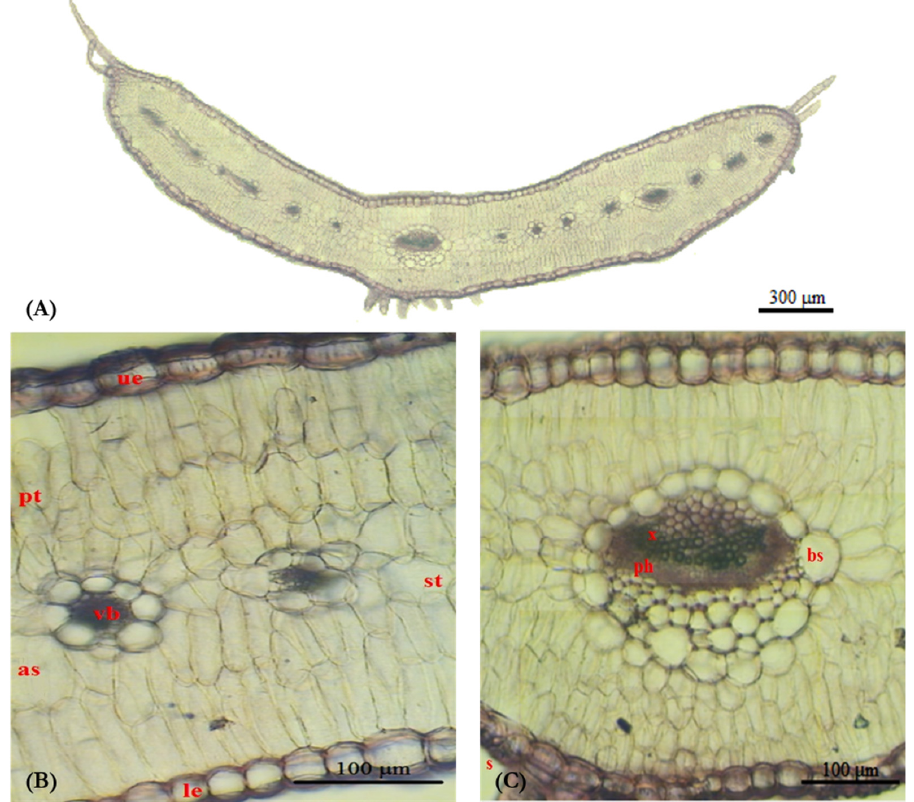
Figure 4. Cross section of the leaf; (A) Ensemble; (B) Portion with mesophyll and secondary veins; (C) Portion of the mid rib